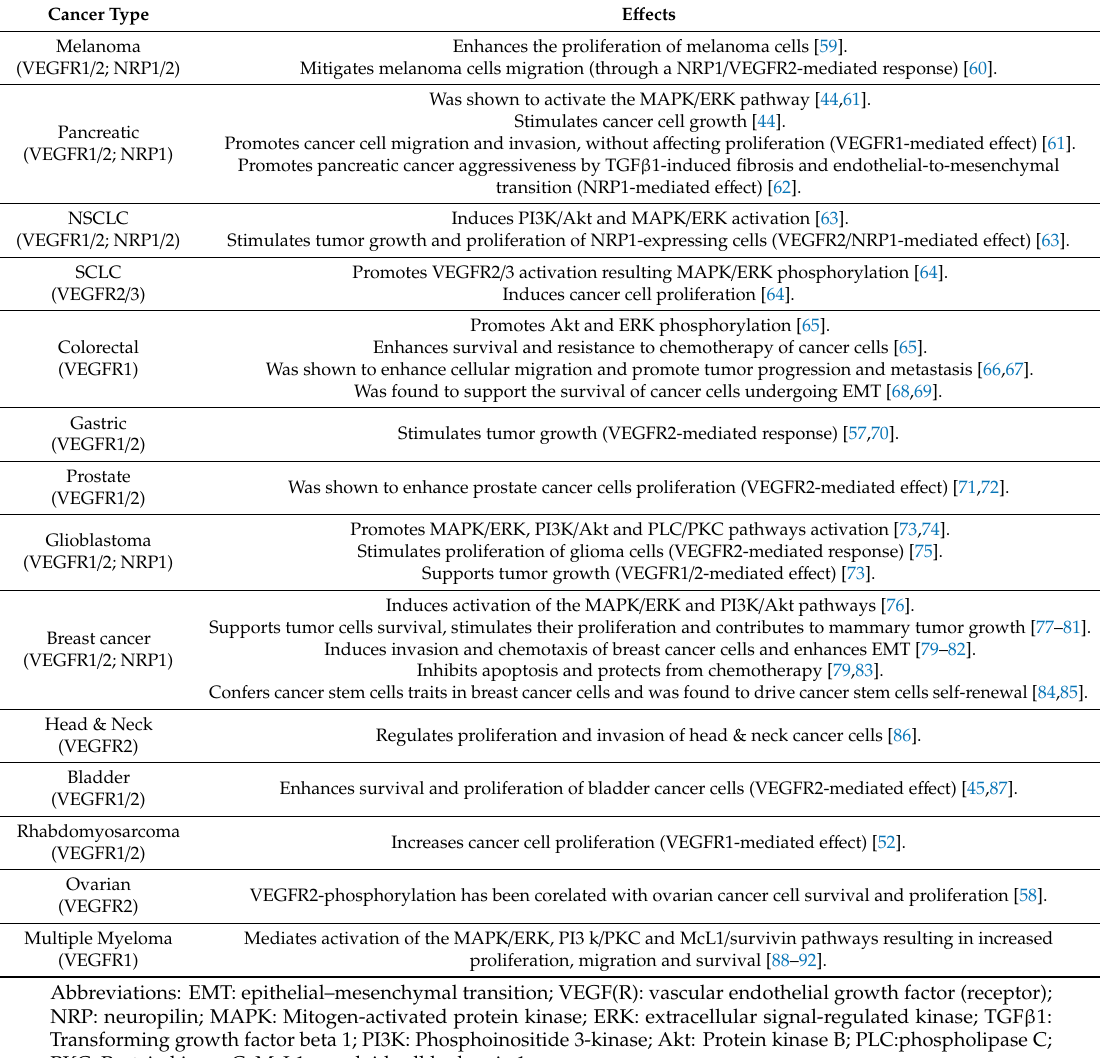
Table 1. E ff ects of VEGF / VEGFR autocrine-paracrine signaling in cancer cells.